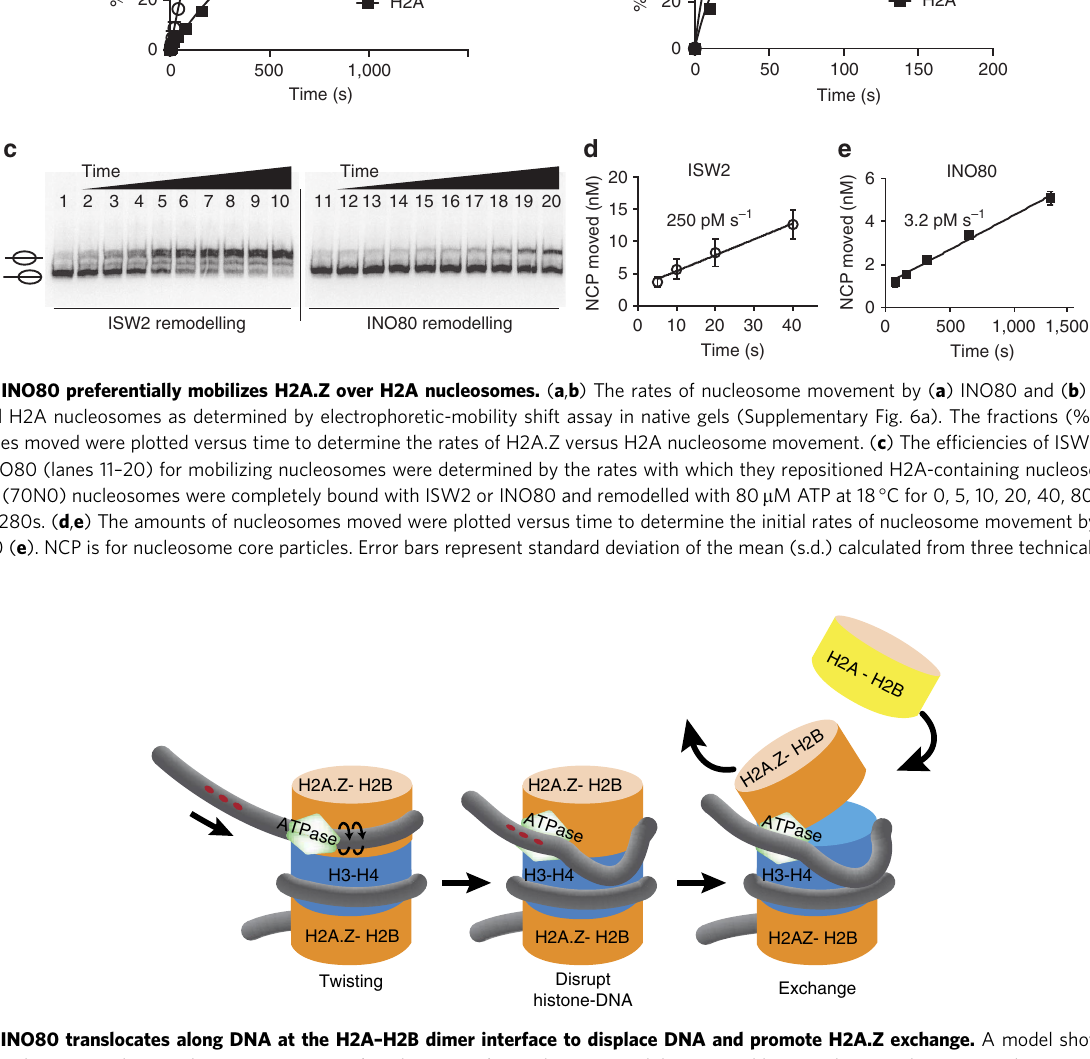
carrier (homogeneous assembly, for ATPase assay only) 36 . DNA and histone octamer were mixed at roughly 1:1 w/w ratio in 2M NaCl, and the salt concentration was diluted in steps down to 280mM with 25mM Tris-HCl (pH 8). Samples were run on 4% native polyacrylamide gel to check for nucleosome assembly. Hydroxyl radical footprinting . DNA with a 5 0 32 P-label on one strand was assembled into end-positioned nucleosome with 70bp of extranucleosomal DNA (70N0). INO80 and ISW2 were bound to nucleosomes in saturating amounts in low-glycerol conditions ( o 0.8%) at 30 (cid:2) C. Cleavage reactions were initiated by DNA was isolated by phenol-chloroform extraction, concentrated by ethanol precipitation at (cid:2) 20 (cid:2) C, and resolved in denaturing 6.5% polyacrylamide gels with 8M urea along with a sequencing ladder made from the same DNA. The data